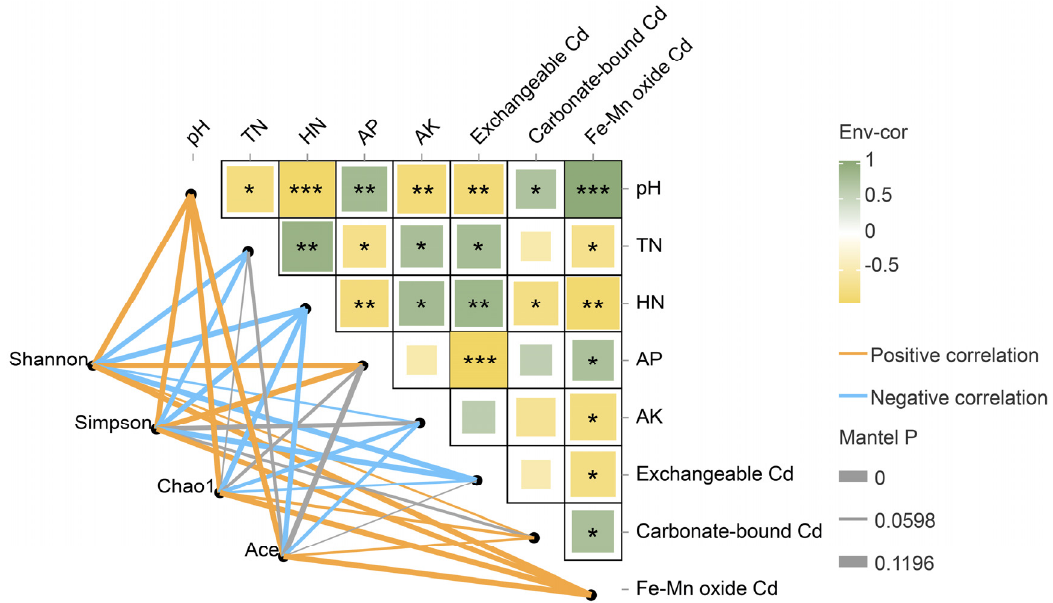
Figure 2. Correlation network between soil physicochemical indices and alpha diversity indices. The color block size in the correlation heatmap indicates the absolute value of the correlation coefficient. *, **, and *** represent 0.01 < p < 0.05, 0.001 < p < 0.01, and p < 0.001, respectively. Orange and blue network lines indicate significantly positive and negative correlations ( p < 0.05), respectively.